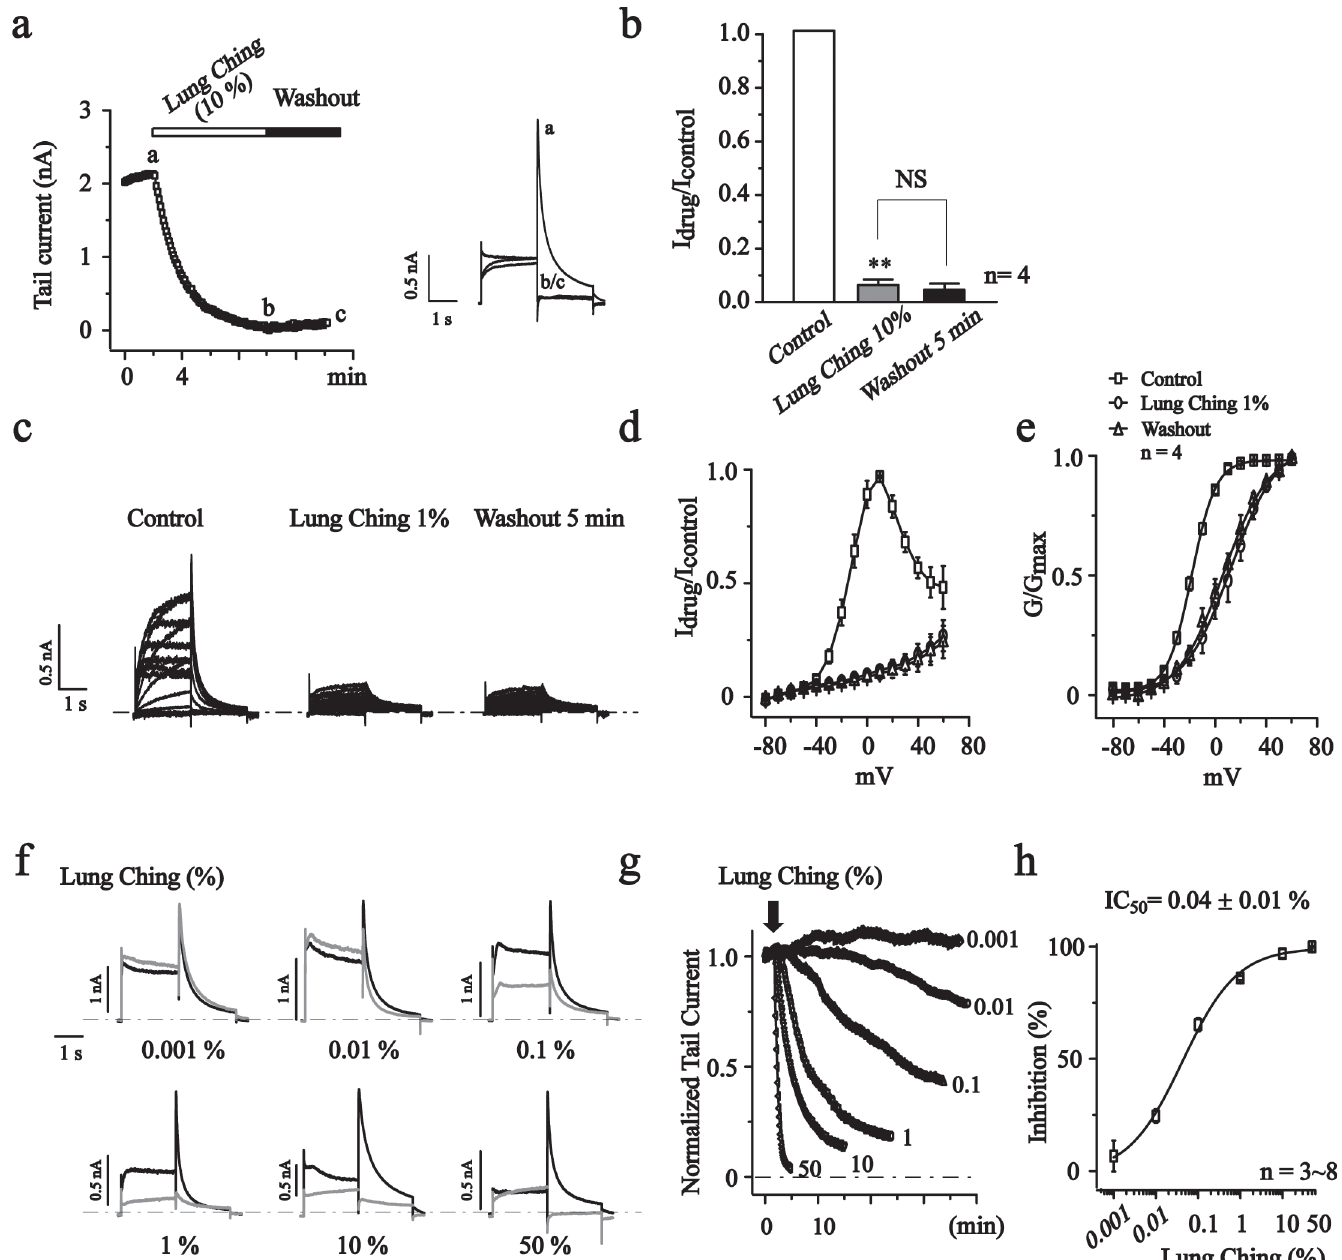
Fig 3. The effects of green tea Lung Ching on hERG currents. (a) The time courses for the effects of Lung Ching (10%) on hERG currents recorded at -60 mV. The right panel showed the current traces recorded at the times indicated by the letters. (b) Summary data of A. ** P < 0.01, NS, no significant. n = 4. (c) Representative traces of hERG currents recorded in the absence (Control) and in the presence of Lung Ching (1%) and after 5 min washout using a voltage step protocol indicated in Fig 2A. (d) Normalized I-V curves of steady-state hERG active currents. (e) Normalized G-V curves constructed from the peak tail currents at -60 mV were fitted with the Boltzmann function. The V 1/2 values were -18.4 ± 0.2 mV for the control, 12.4 ± 1.1 mV for Lung Ching (1%), and 6.2 ± 0.8 mV for 5 min washout, n = 4. (f) The effects of different concentration of Lung Ching were shown (black trace: control, gray trace: Lung Ching). (g) The time courses of concentration-dependent modulation of the hERG currents recorded at -60 mV. (h) Concentration-response relationship of Lung Ching on hERG currents (-60 mV, n = 3~8). The curve was fitted with the logistic function. The IC 50 is 0.04 ± 0.01%.